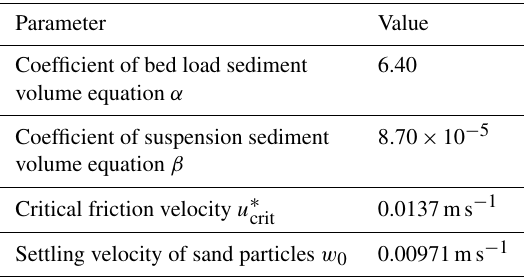
Table 2. Set parameters for sediment transport